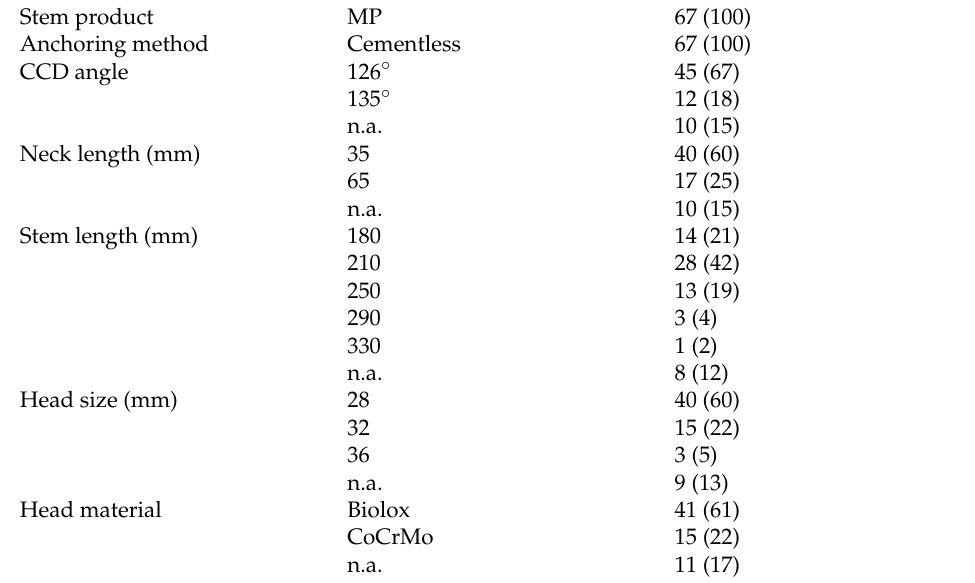
Table 2. Details of implanted